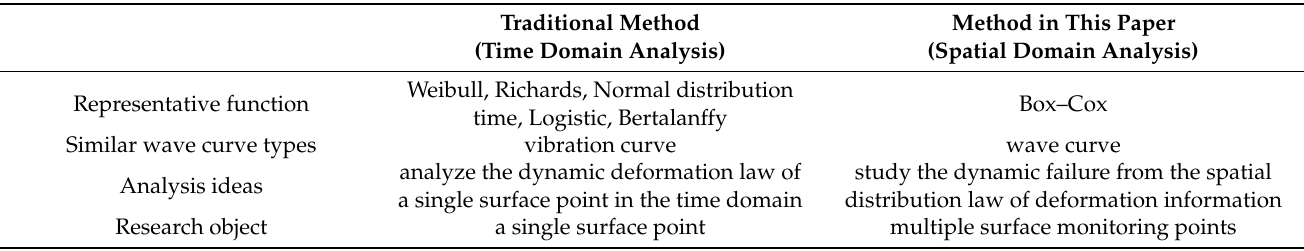
Figure 2. Propagation diagram of wave curve. ( a ) Vibration curve. represents the displacement of a single point at each time. ( b ) Wave curve. represents the displacement of each particle at a certain time. Table 2. Differences with traditional analysis